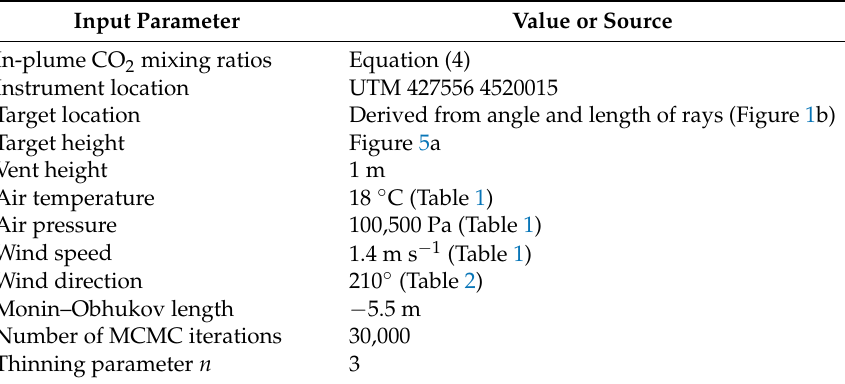
Table 2. Input parameters expected by the Bayesian